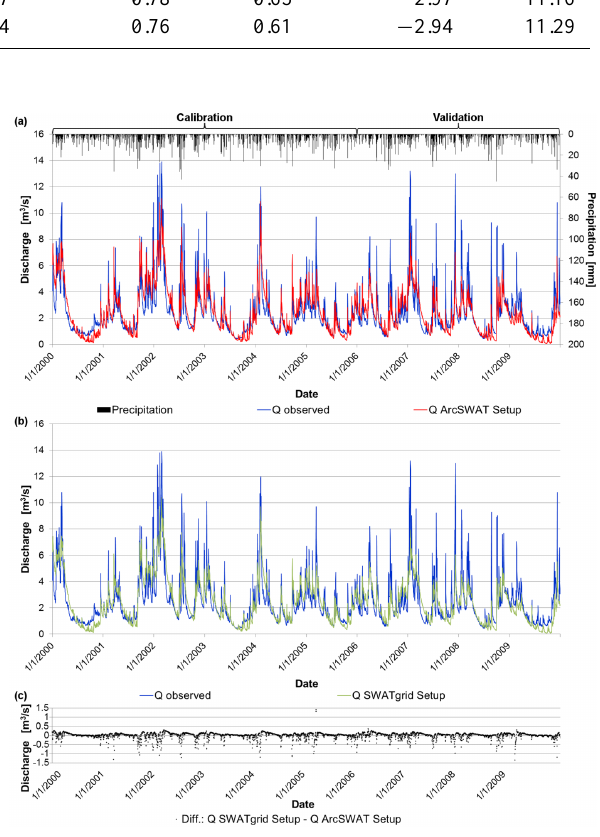
Fig. 4. Measured and simulated daily discharge (calibration